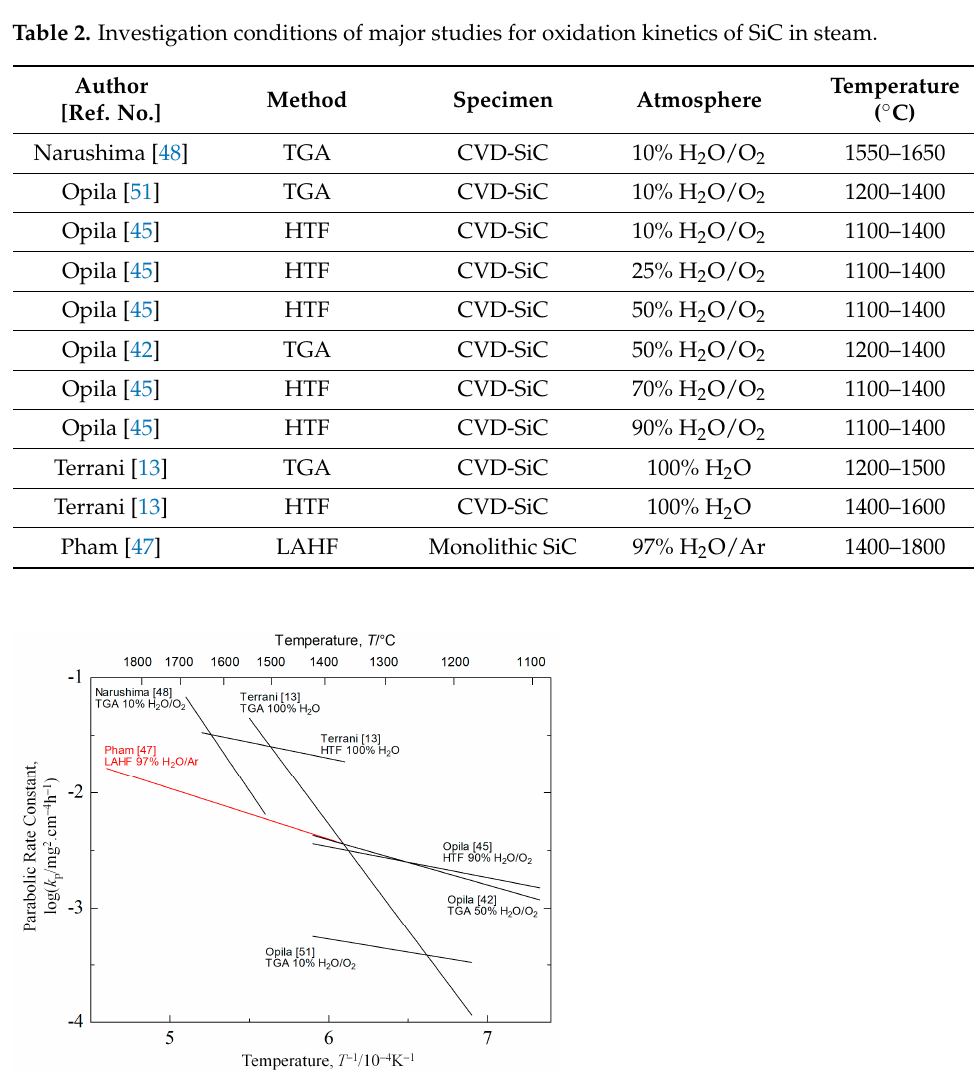
Figure 6. Major reports on the parabolic oxidation rate, k p , of SiC in steam at high temperatures.